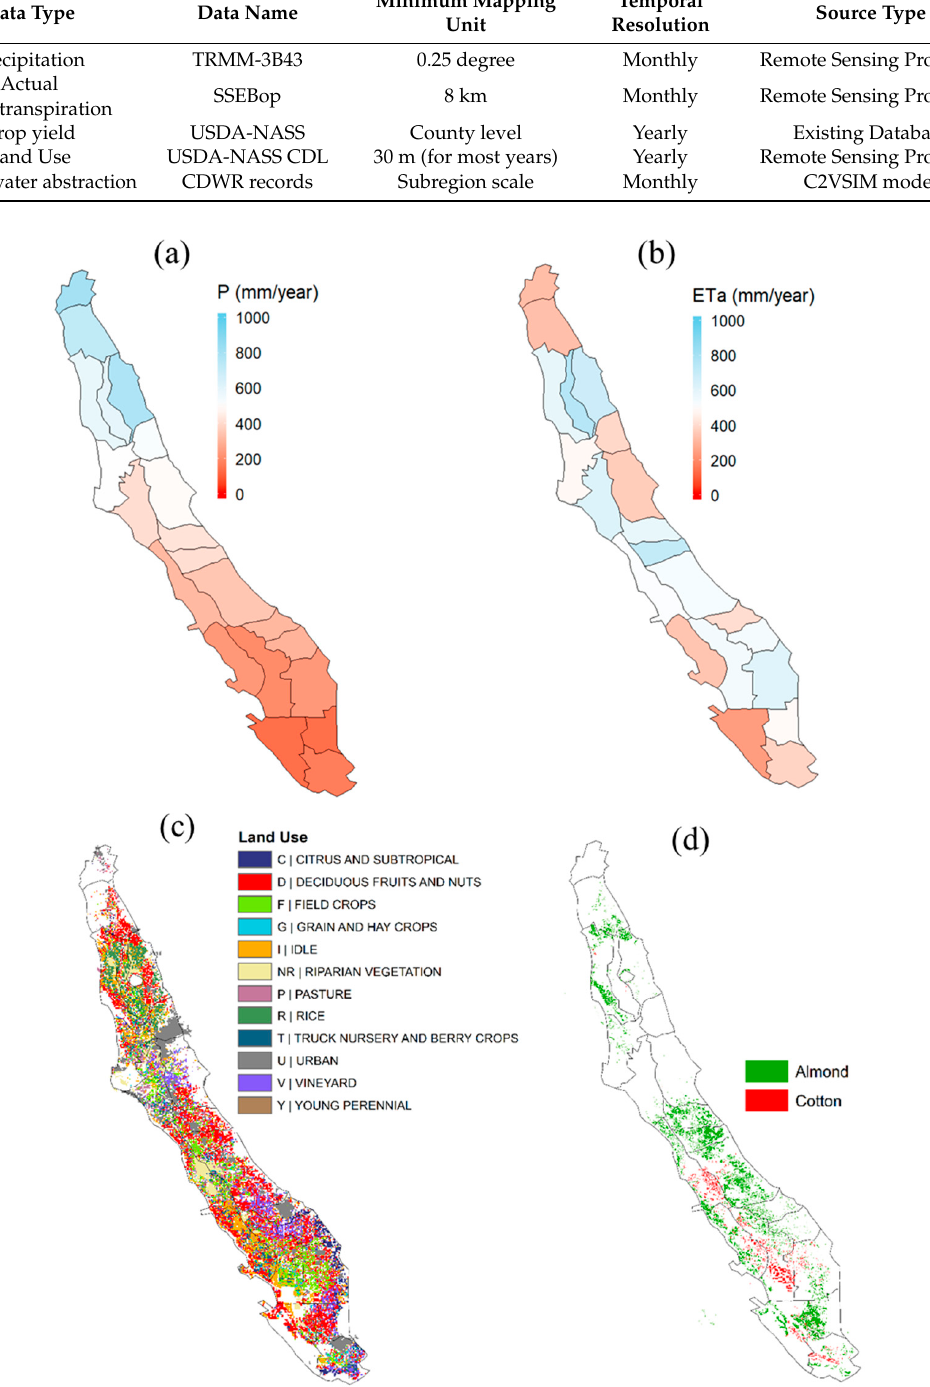
Figure 3. Climate and land use conditions in CV. ( a ) Mean annual precipitation and ( b ) mean annual ETa in the CV (averaged over the period 2007–2018). The precipitation and ETa data are obtained from TRMM-3B43 and SSEBop. Spatial distribution of ( c ) major cropping pattern and ( d ) almond and cotton in 2014. The land use data is available through CDWR at https://gis.water.ca.gov/app/cadwrlanduseviewer/ .